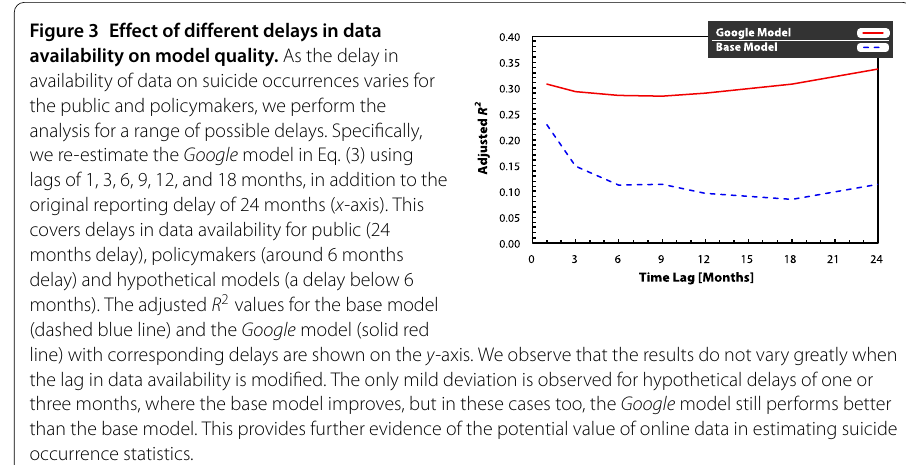
Figure 3 Effect of different delays in data availability on model quality. As the delay in availability of data on suicide occurrences varies for the public and policymakers, we perform the analysis for a range of possible delays. Specifically, we re-estimate the Google model in Eq. (3) using lags of 1, 3, 6, 9, 12, and 18 months, in addition to the original reporting delay of 24 months ( x -axis). This covers delays in data availability for public (24 months delay), policymakers (around 6 months delay) and hypothetical models (a delay below 6 months). The adjusted R 2 values for the base model (dashed blue line) and the Google model (solid red line) with corresponding delays are shown on the y -axis. We observe that the results do not vary greatly when the lag in data availability is modified. The only mild deviation is observed for hypothetical delays of one or three months, where the base model improves, but in these cases too, the Google model still performs better than the base model. This provides further evidence of the potential value of online data in estimating suicide occurrence